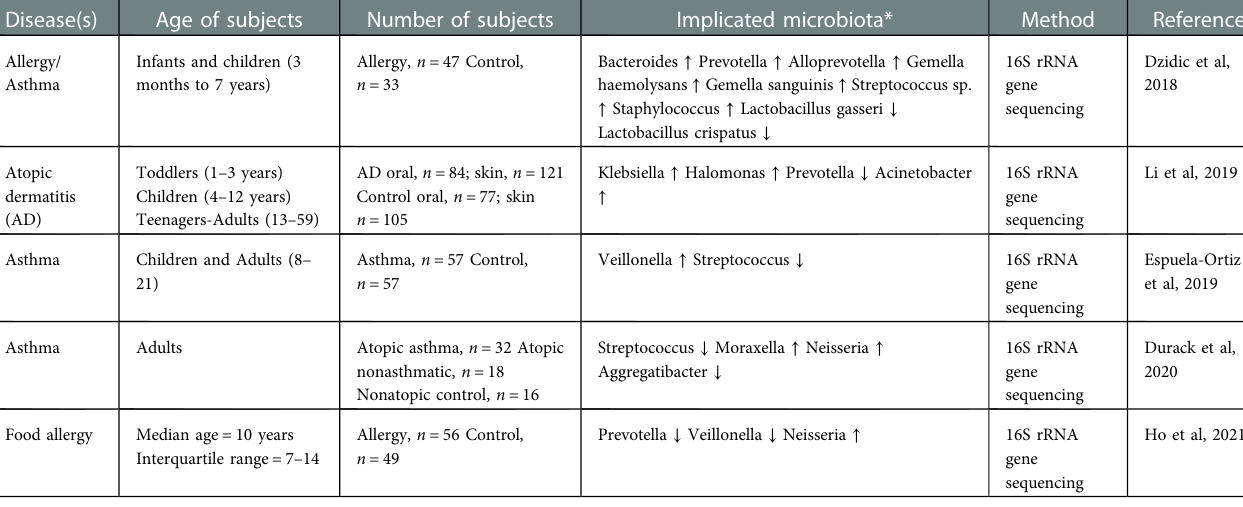
TABLE 1 Summary of recent studies that identify oral microbiota associated with allergic disease